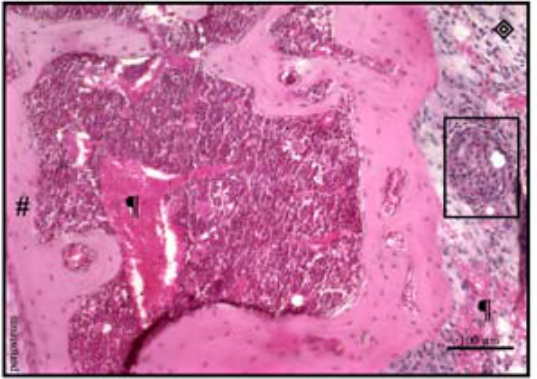
FIGURE 2 - Photomicrograph evidencing the microscopic aspect of the process of bone defect repair at 10 days in an animal from group MSC/ PRP (MPG). Presence of large numbers of undifferentiated cells inside the fault (  ), early organization of cells present within the defect (rectangle) around a blood vessel, replacement of blood clot ( ¶ ) and receptor bone ( # ). (H & E)